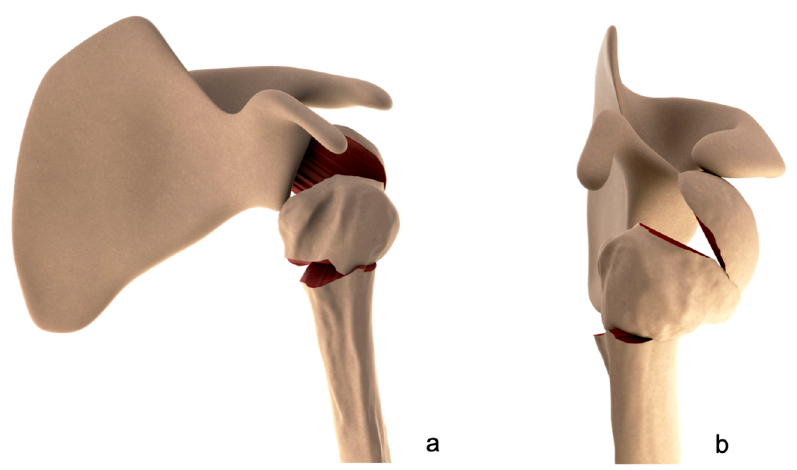
Figure 1. Left shoulder. Posterior Approach to the shoulder joint. The posterior capsule is injured,